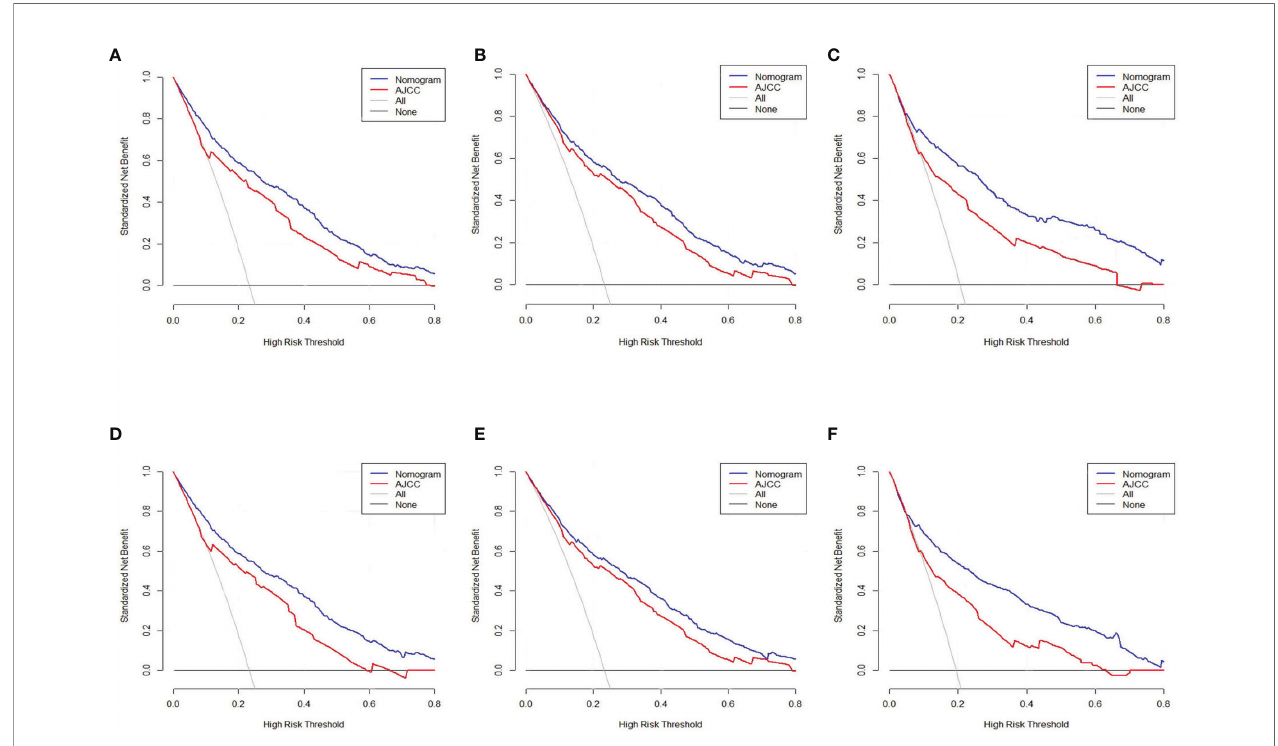
FIGURE 6 | Decision curve assessment of the nomogram along with the AJCC staging approach in the estimation of the CSD of individuals with PC at 3 and 5 years in the test cohort (A, D) , internal veri fi cation (B, E) , and external veri fi cation (C, F)